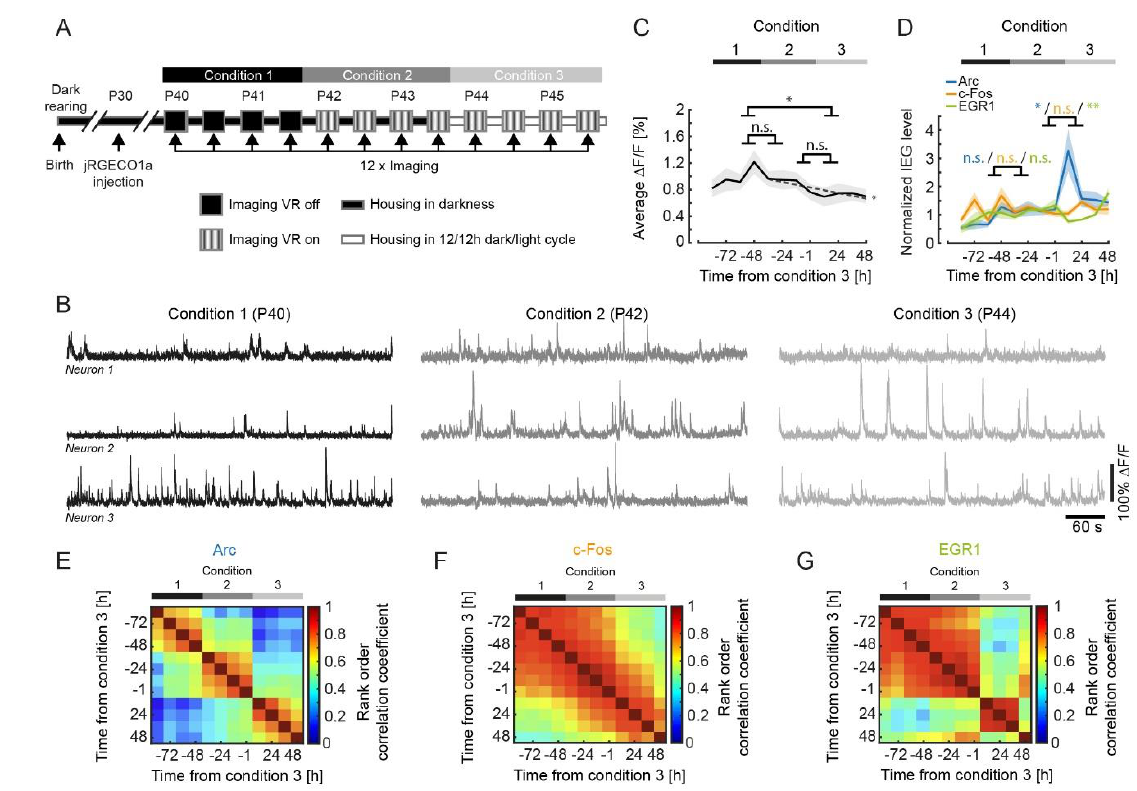
Figure 2. IEG expression dynamics during visuomotor